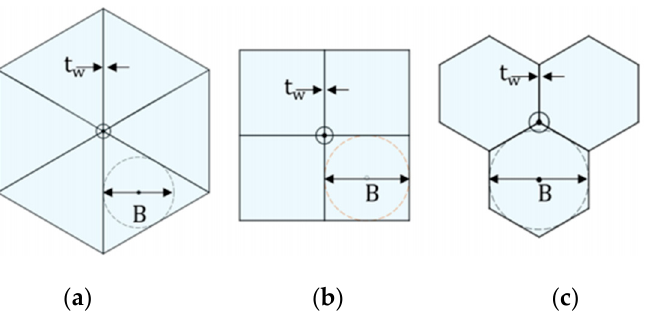
Figure 5. Typical lightweight unit: ( a ) triangular cell; ( b ) square cell; ( c ) hexagonal cell.